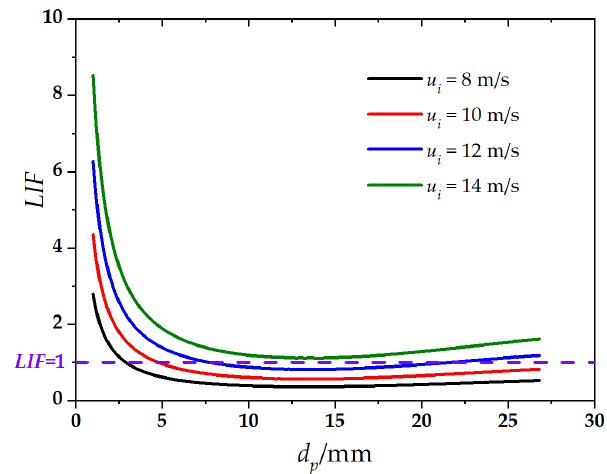
Figure 10. Relation between lift index and particle diameter under four different u i . The velocity, pressure and lift index profile with increased h / R at u i = 10 m/s and H / d p = 3 are shown in Figures 11–13, respectively. The highly curved (with high h / R